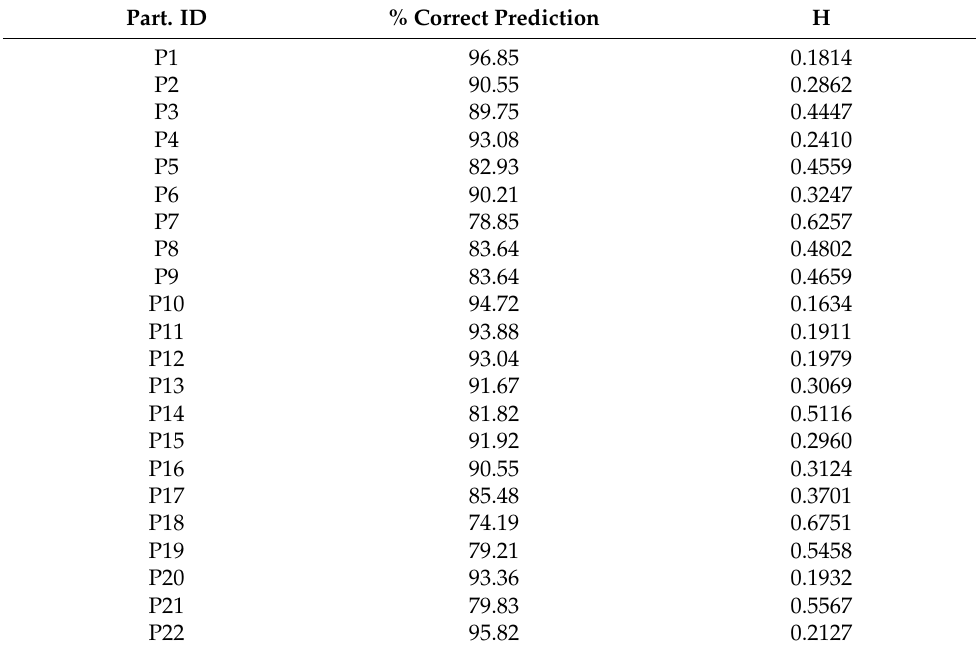
Table 3. Results for the PRNN for the classification related to the three classes.